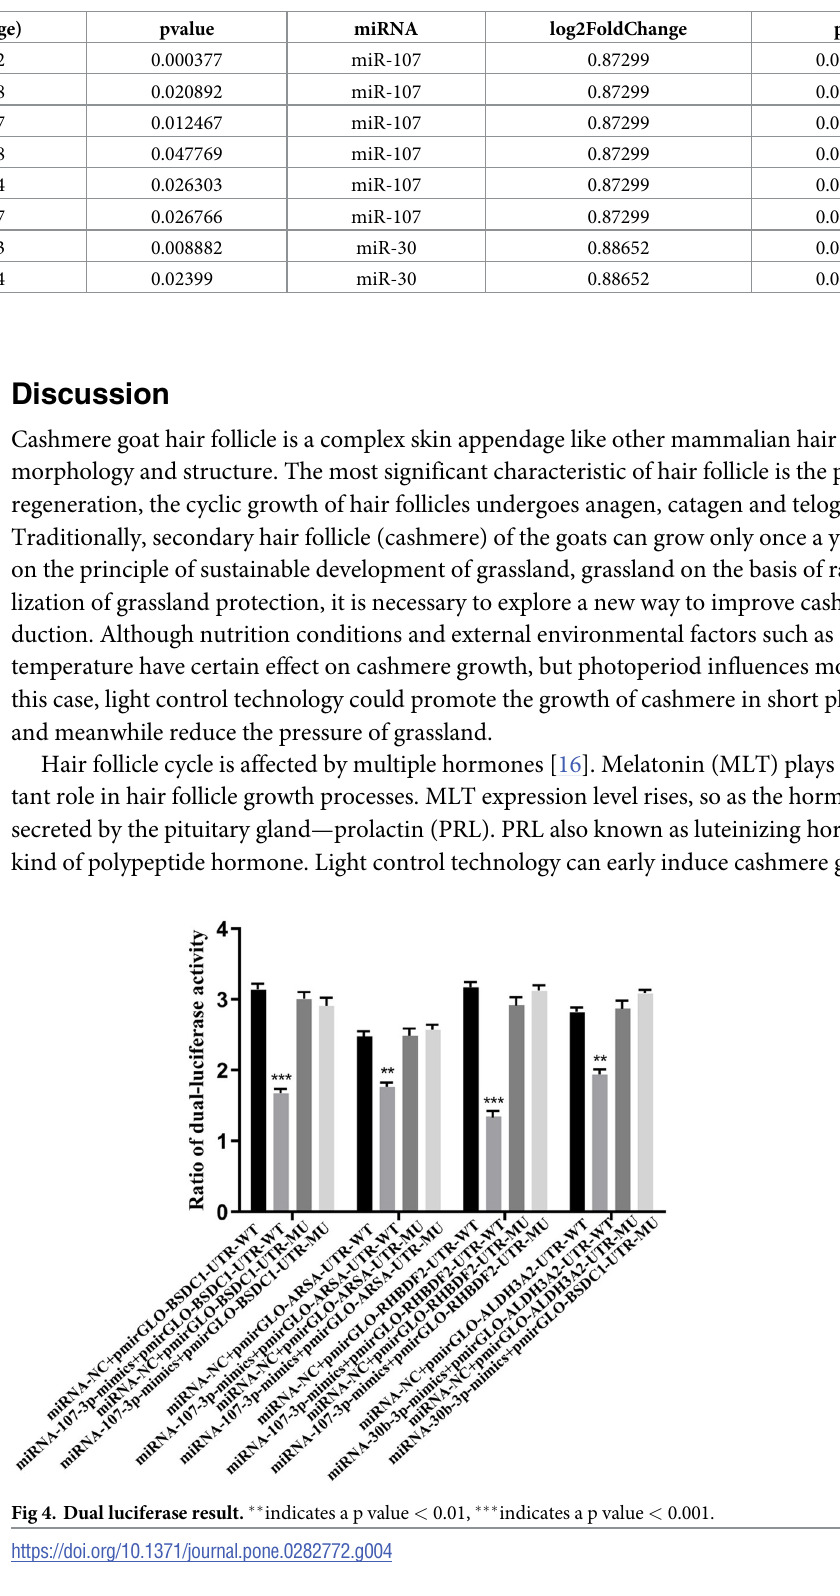
Table 4. Correlation analysis of mRNA and